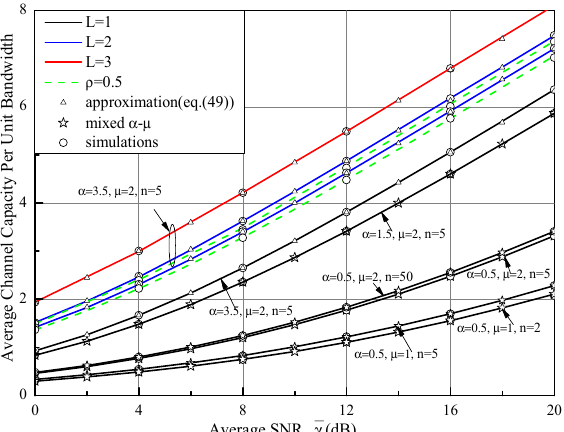
Figure 7. Average channel capacity per unit bandwidth of various communication systems as a function of the average SNR ( 𝛾̅ ) over different α - μ /IGA fading channels.